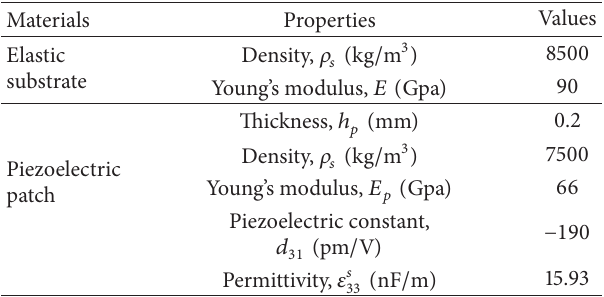
Table 3: Material properties of the bimorph cantilever beam. Materials